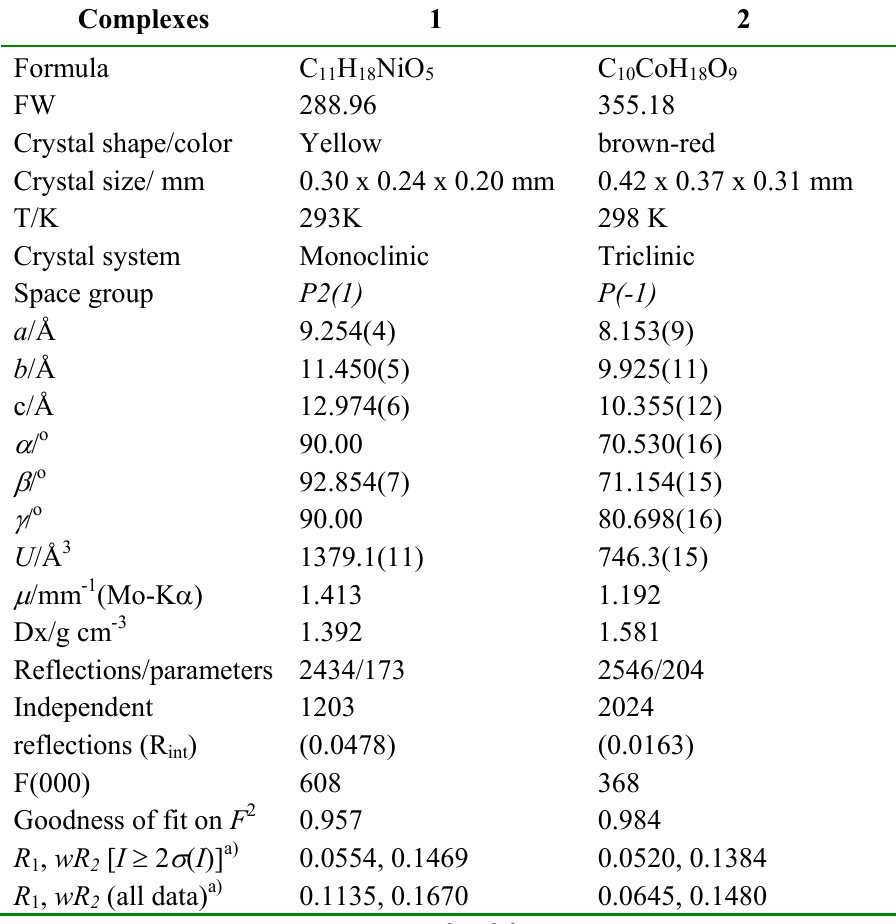
Table 1 Crystallographic and experimental data for complexes 1 and